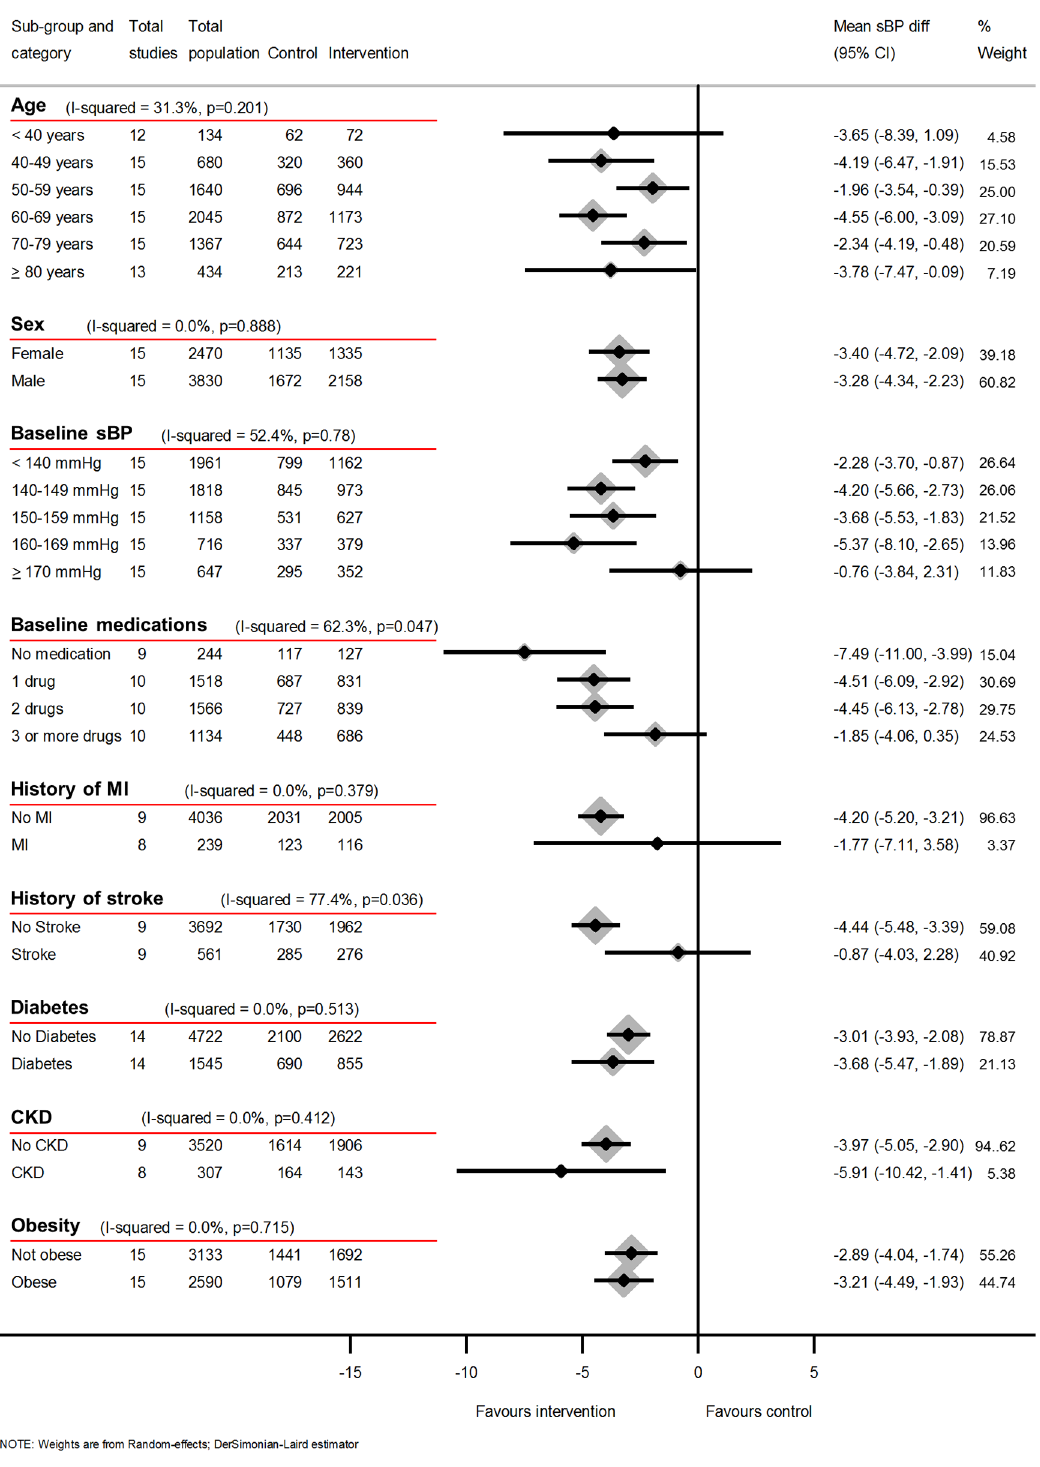
Fig 6. Impact of self-monitoring of BP on clinic sBP at 12 months according to prespecified subgroups (15 studies). Obesity definedas BMI (cid:21) 30 kg/m 2 . Changein sBP at 12 months adjustedfor age, sex, baselineclinic BP, level of intervention, and studies contributing patient data. Abbreviations: BMI, body mass index; BP, blood pressure; CKD, chronickidney disease;MI, myocardial infarction; sBP, systolic blood pressure.